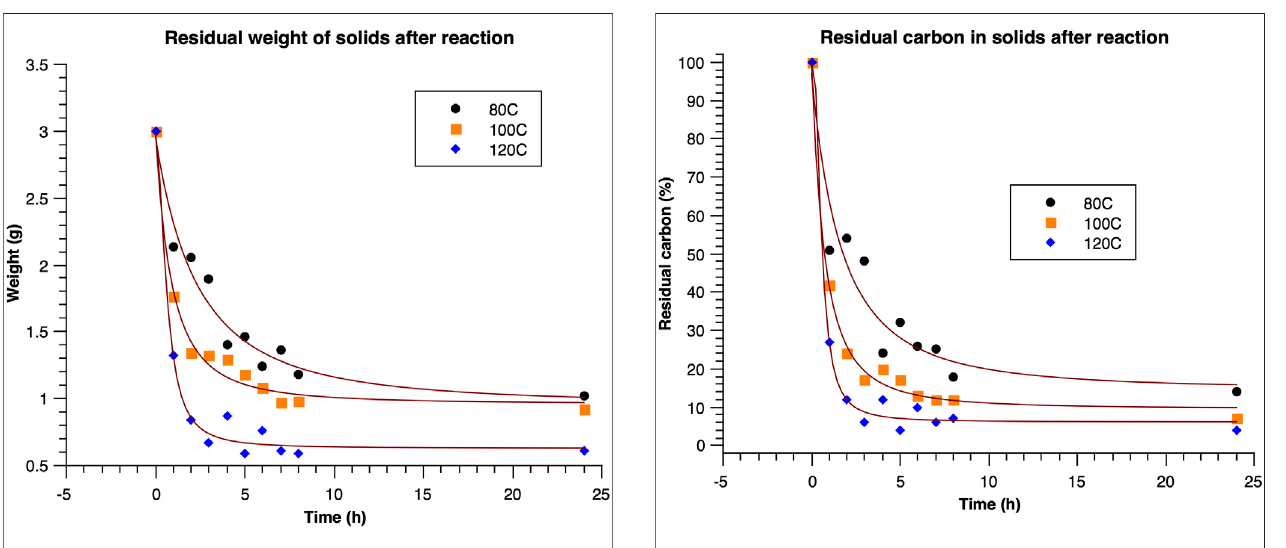
FIGURE 1 | Residual weight of solids after oxidation ( fi tted curves are provided for visualization purposes only).